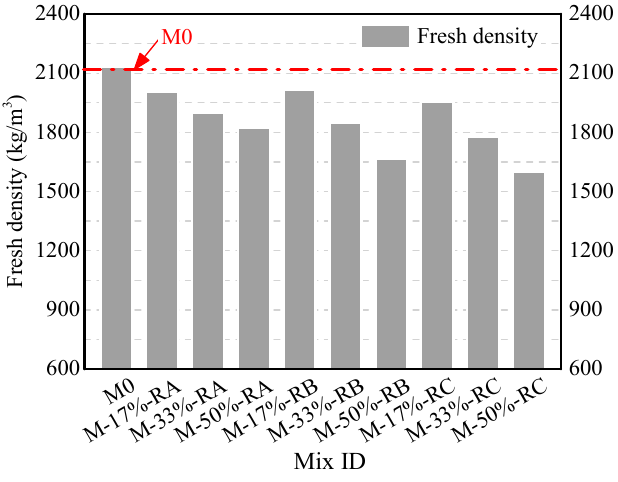
Figure 6. Fresh density of crumb rubber mortars.